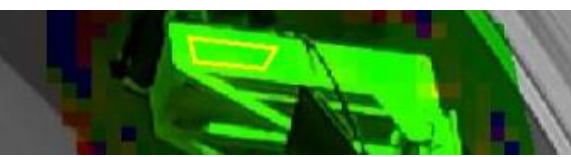
Figure 6: Reference area on the Scanner support for deformation analysis: Yellow outlined area on the Scanner